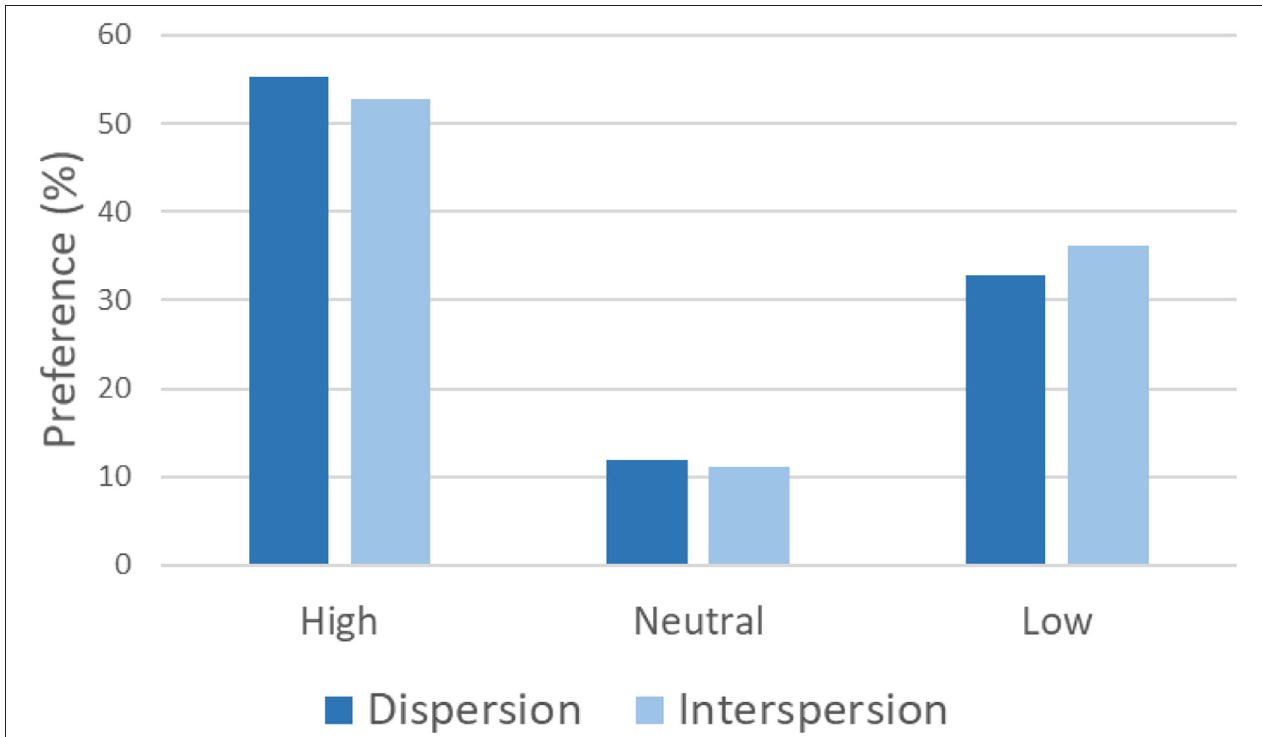
FIGURE 3 | Distribution of preferences for landscapes differing in dispersion and interspersion levels. Neutral showed the cases in which participants expressed an intermediate preference between the “high” and “low” specimens.